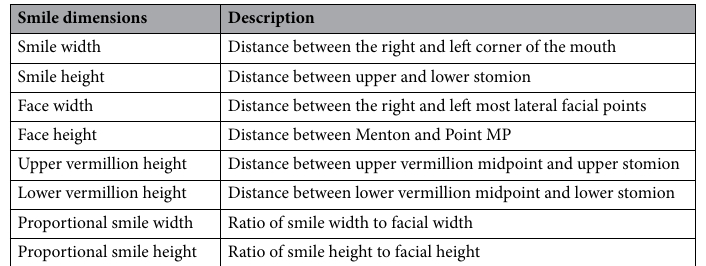
Table 1. Description of measured smile dimensions.